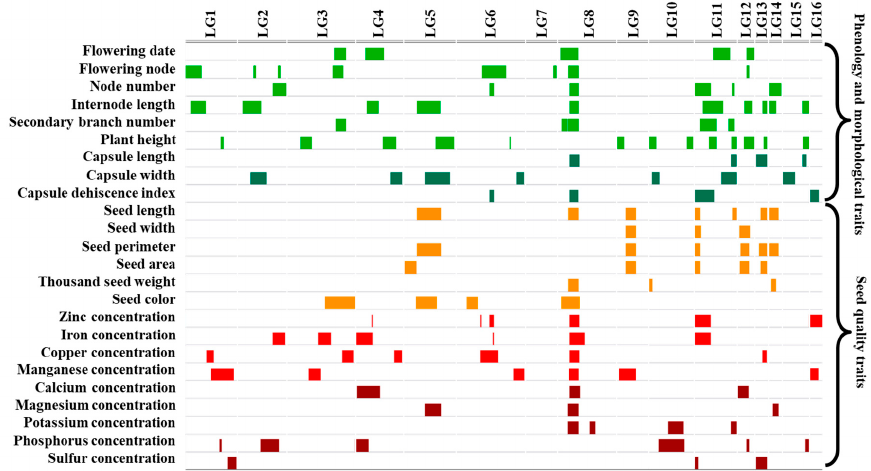
Figure 3. Genomic architecture of agronomical important traits in sesame. For each trait, the significant associated loci indicated by rectangles across sesame genome linkage groups (LG). Plant (green) and capsule (dark green) phenological and morphological traits. Seed quality (orange), micronutrients (red) and macronutrients (burgundy) concentrations.